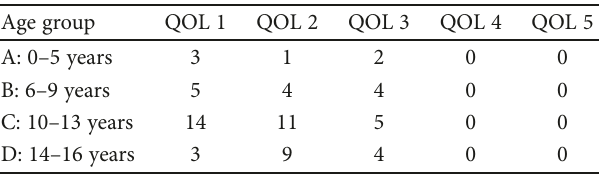
Table 6: IV injection and quality of life score with respect to the age